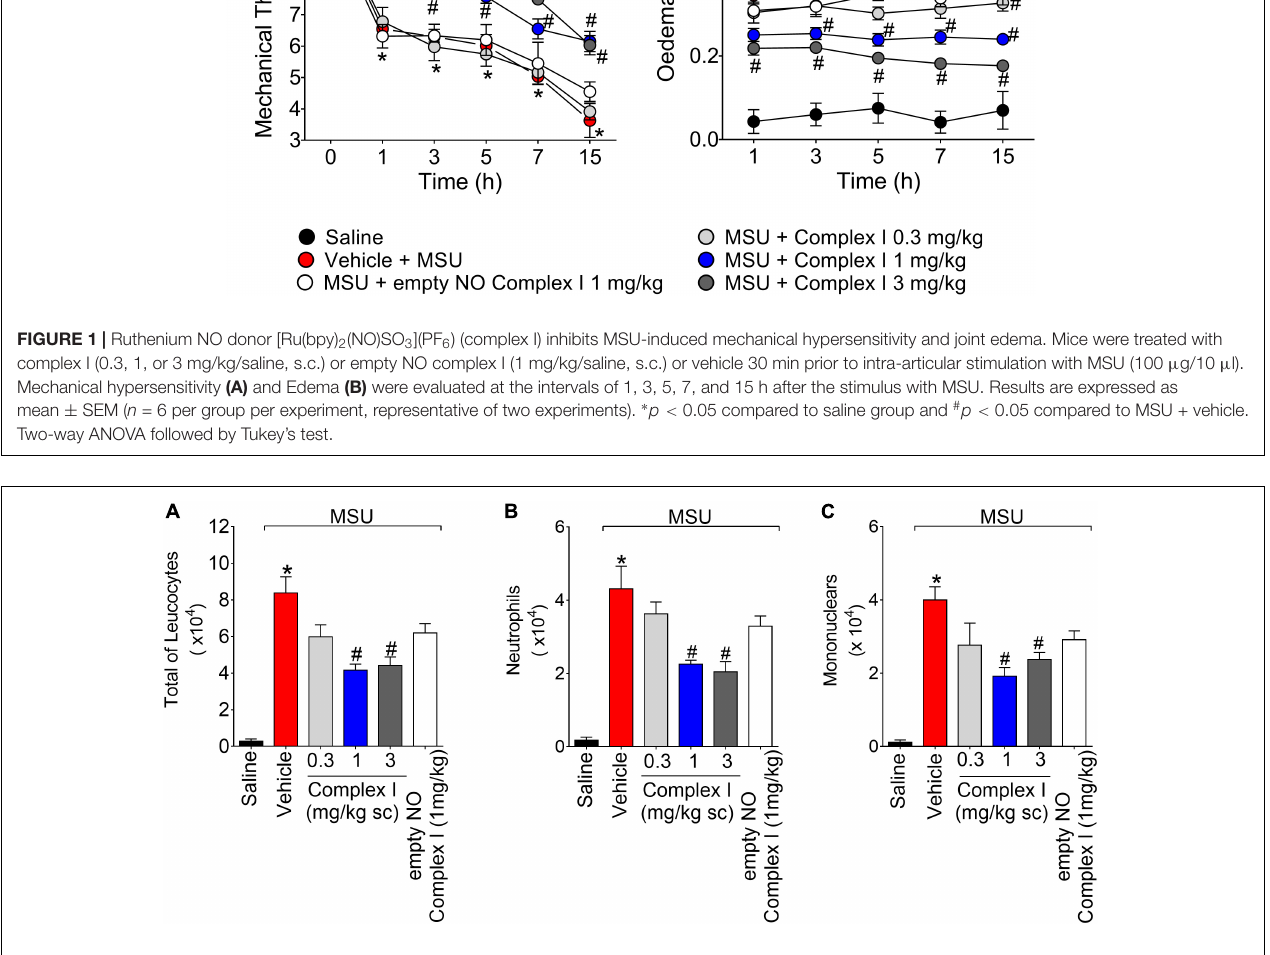
FIGURE 2 | Complex I inhibits MSU-induced leukocyte recruitment in the knee joint cavity. Mice were treated with complex I (0.3, 1, or 3 mg/kg/saline, s.c.) or empty NO complex I (1 mg/kg/saline, s.c.) or vehicle 30 min prior to intra-articular stimulation with MSU (100 µ g/10 µ l). Total leukocytes (A) and differential counts of polymorphonuclear (B) and mononuclear (C) cells in synovial fluid were performed 15 h after MSU stimulus. Results are expressed as mean ± SEM ( n = 6 per group per experiment, representative of two experiments). ∗ p < 0.05 compared to saline group and # p < 0.05 compared to MSU + vehicle. One-way ANOVA followed by Tukey’s